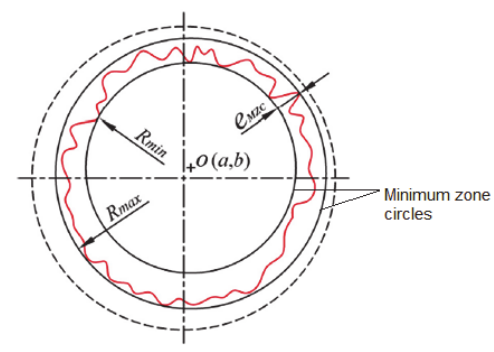
Fig. 2. Minimum zone circles fitted for roundness error (Du et al.,